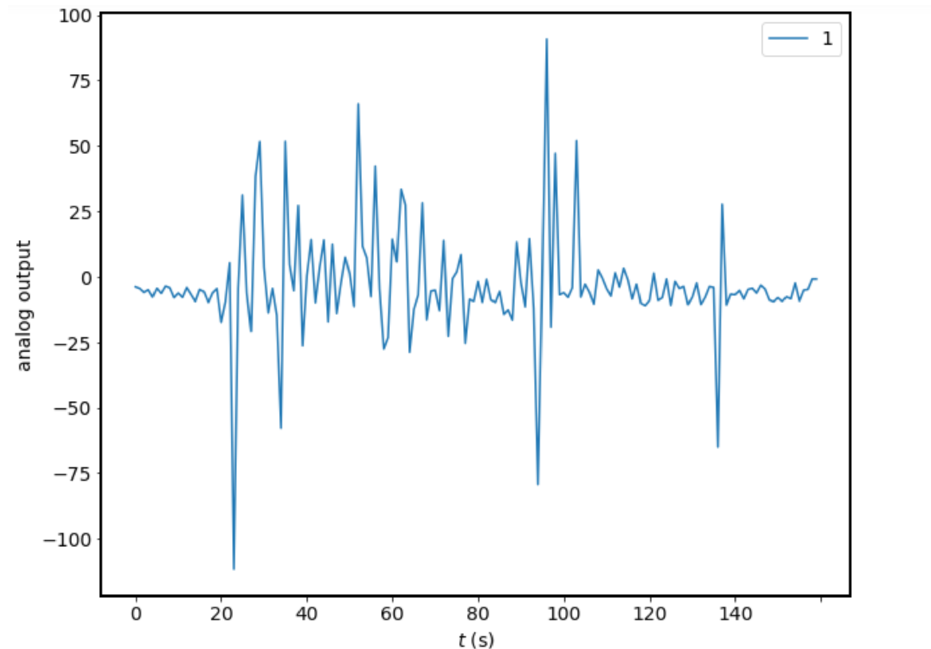
Figure 7. Example of Vibration data.